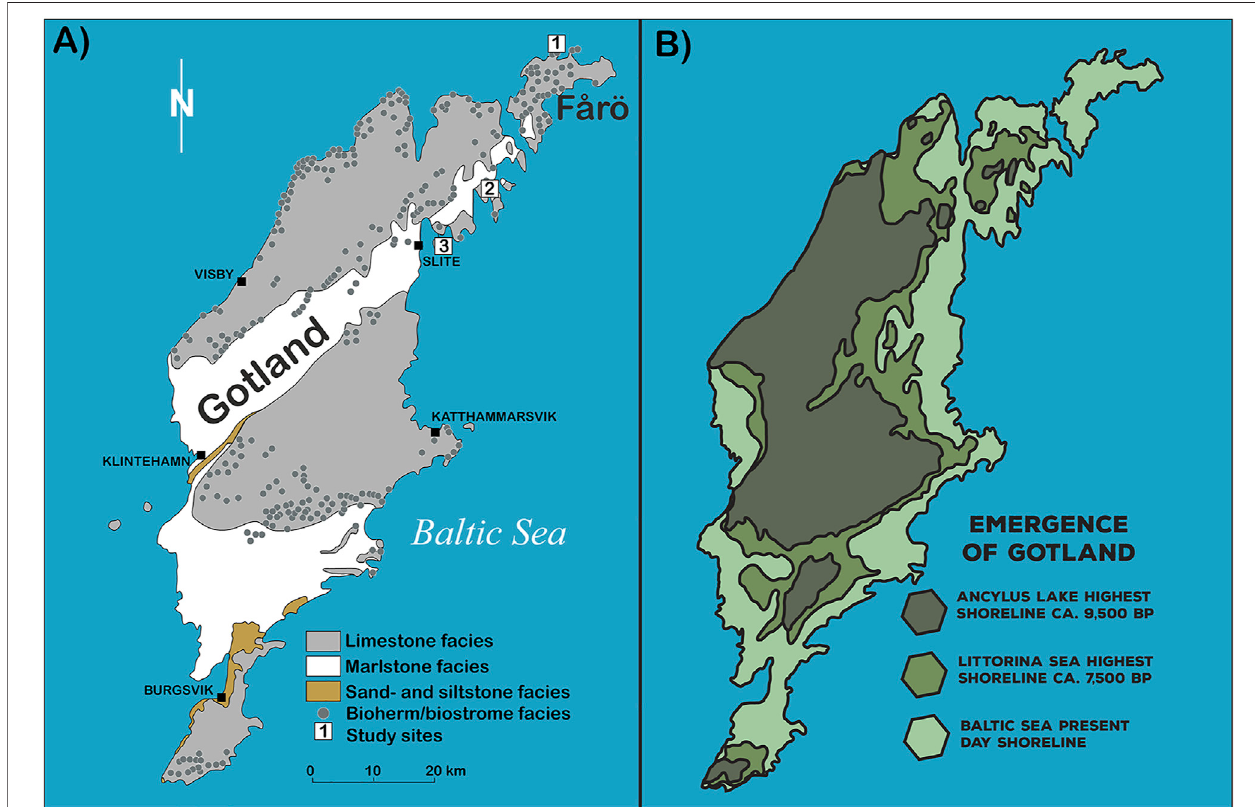
FIGURE 2 | (A) Simpli fi ed map of Gotland ’ s geology. Dark grey dots mark the location of reef facies in limestones that compose rauk fi elds. 1 — study site in Langhammars, 2 — study site in Lergrav, 3 — study site in Asundens; (B) emergence of coasts of Gotland delimited by highest shorelines of Ancylus Lake, Littorina Sea, and modern